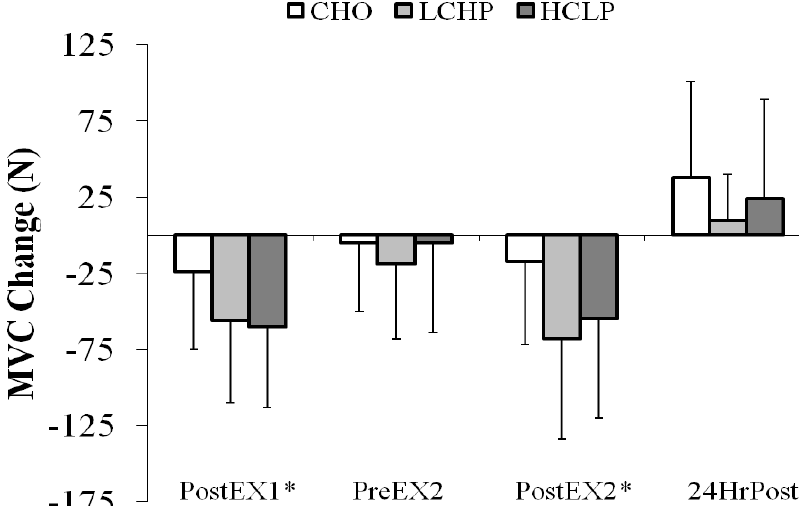
Figure 4. Influence of Exercise and Recovery Beverages on MVC (Mean ±